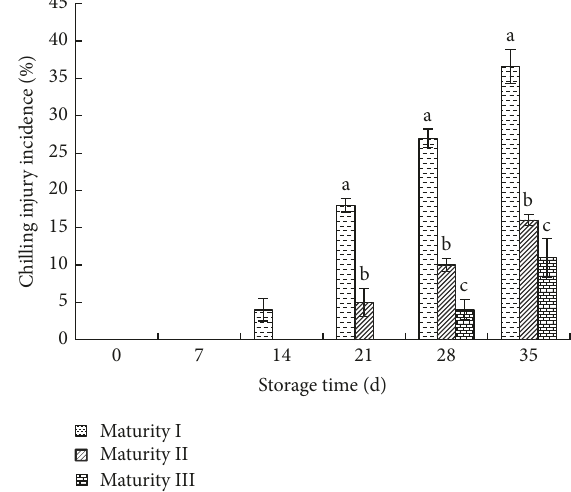
Figure 2: Effects of harvest maturity on the incidence of chilling injury in apricots; fruits with maturity class I (colored area < 50%), maturity class II (colored area 50–80%), and maturity class III (colored area > 80%) were categorized according to the yellow conversion rate. Vertical bars represent the standard errors of the means of triplicate replicates. a, b, c = bars at each storage time point have different letters which are significantly different at P < 0.05.